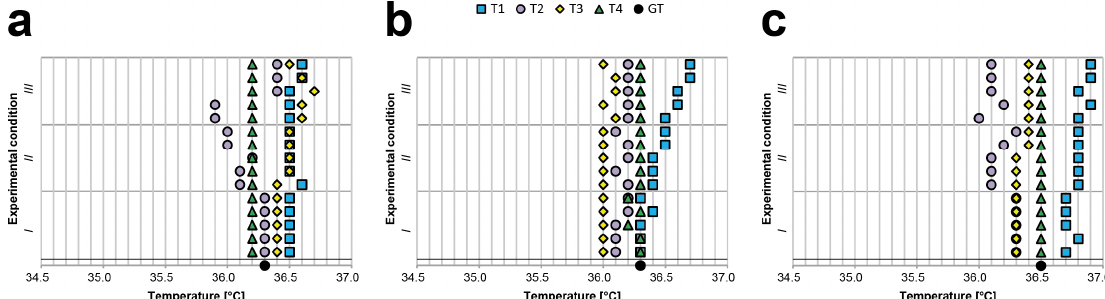
Figure 6. Visual representation of the temperature data (reported on the x -axis in °C) collected during the light influence experiment. We positioned the thermometers perpendicular to the forehead of Subject 1/Subject 2/Subject 3 and maintained the TECNIMED VisioFocus PRO 06480 at a 7 cm distance, the Medek MDI261 at a 3 cm distances, and the other two thermometers at 5 cm distances. We then acquired five measurements for each device under three different conditions of light (i.e., I , II , III , as described in the text); ( a ) Subject 1, ( b ) Subject 2, and ( c ) Subject 3 values.